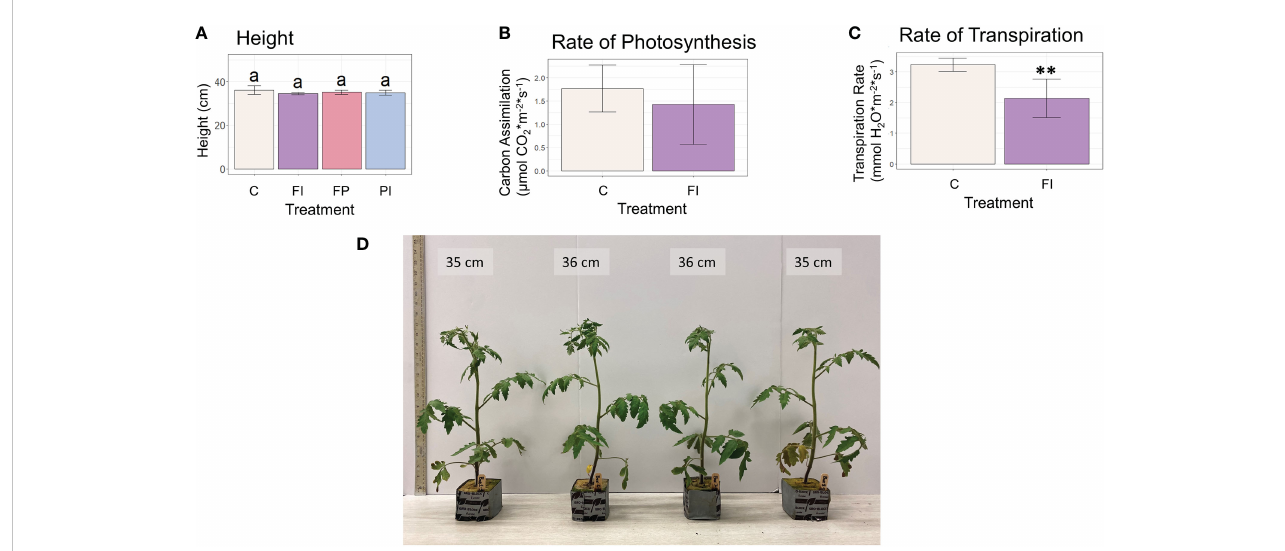
FIGURE 4 Height and carbon assimilation in tomato plants. (A) Height of tomato plants at 30 days. (B) Rate of photosynthesis of tomato plants under the FI fi lter relative to the un fi ltered control. Although the average rate was lower under FI fi ltered light, this difference was not statistically signi fi cant due to the large variation within the treatment. (C) Rate of transpiration under the FI fi lter relative to the un fi ltered control. The FI treatment was signi fi cantly lower than control (** indicates signi fi cance at p<0.01). (D) Photo of representative tomato plants at 30